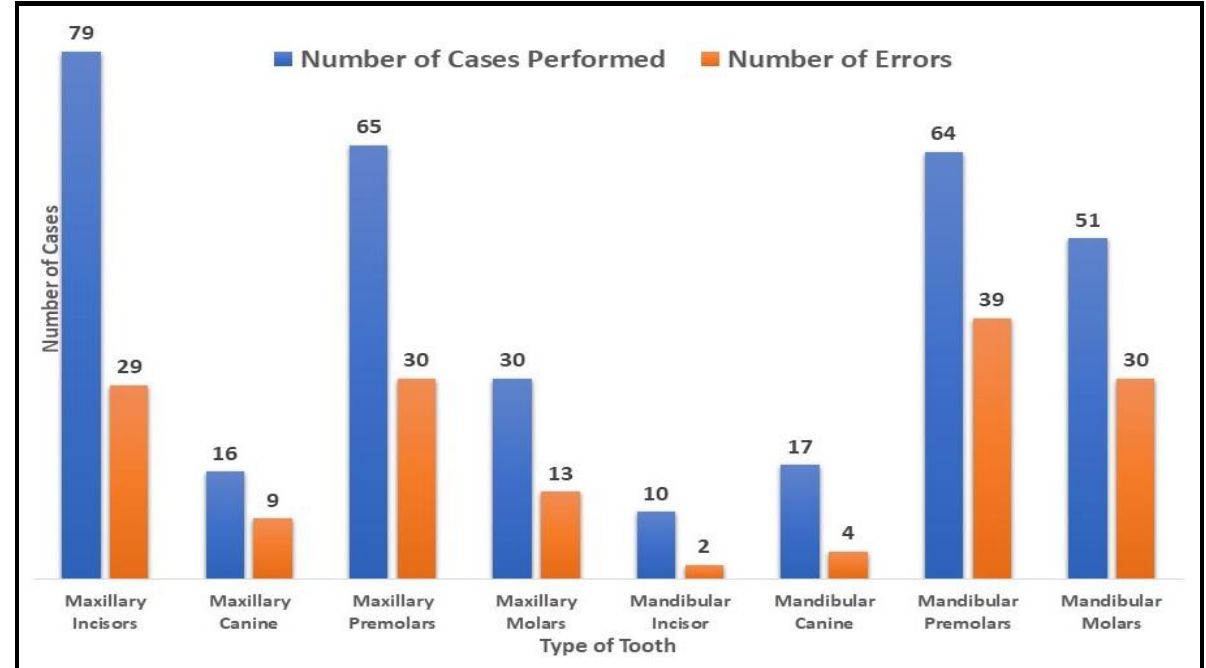
Figure 2. Number of endodontic treatments performed (root canal-wise) by students of different academic levels.